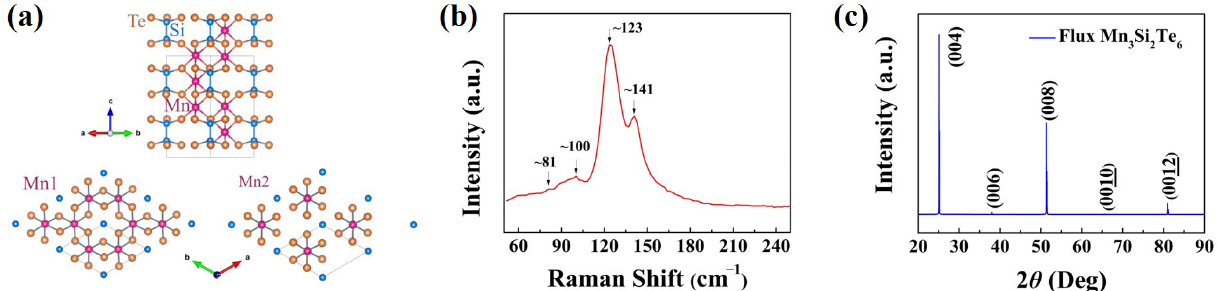
Figure 1. Crystal structure and characterizations: ( a ) crystal structure of Mn 3 Si 2 Te 6 . The Mn atoms are located at the center of the MnTe 6 octahedra (colored regions), which stack along the c axis in honeycomb (Mn1) and triangular (Mn2) layers. ( b ) Raman spectra of Mn 3 Si 2 Te 6 single crystal at room temperature and 1 atm. ( c ) X-ray diffraction pattern of the Mn 3 Si 2 Te 6 crystal recorded on the (00L) plane at room